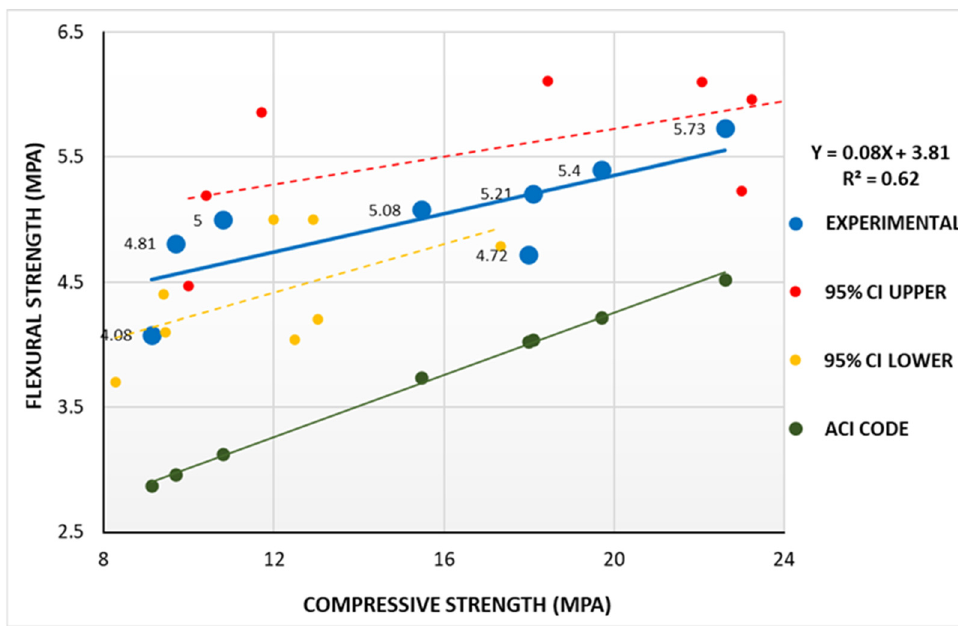
Figure 20. The relationship between flexural and compressive